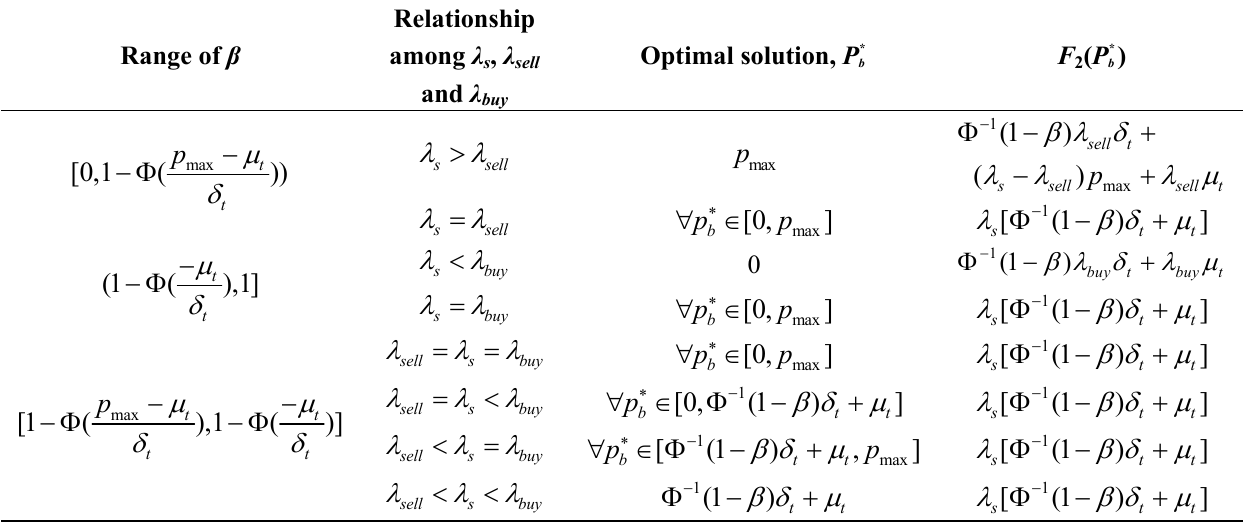
Table 1. Optimal results of chance-constrained programming-based bidding model. Range of β